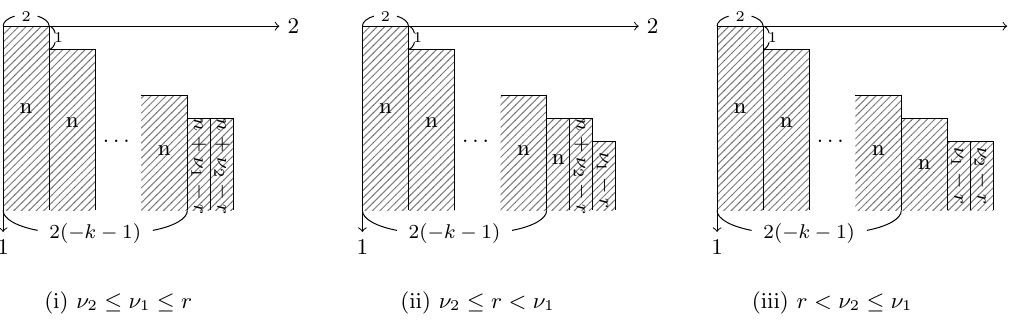
Figure 10 . k < 0 case. There are three types depending on (cid:23) 1 ; (cid:23) 2 and r . We denote the height to x 3 direction by the number written in each